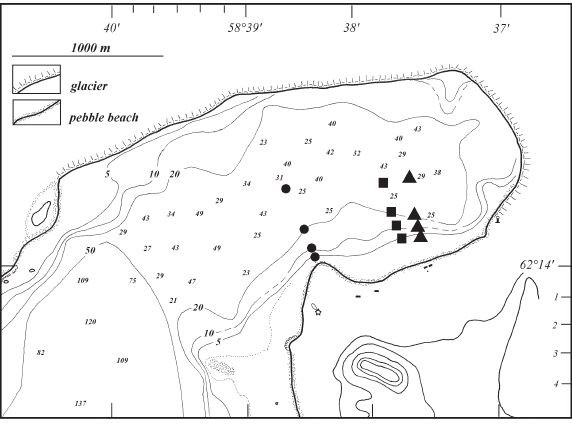
F IG . 1. – Map of Potter Cove, King George Island, Antarctic with bathymetric contours, additional single depths (modified after: Atlas Hidrografico, Chile) and transect locations. Black triangles: Transect 1, inner cove; black dots: Transect 2, cove entrance; black squares: transect sampled by Mayer